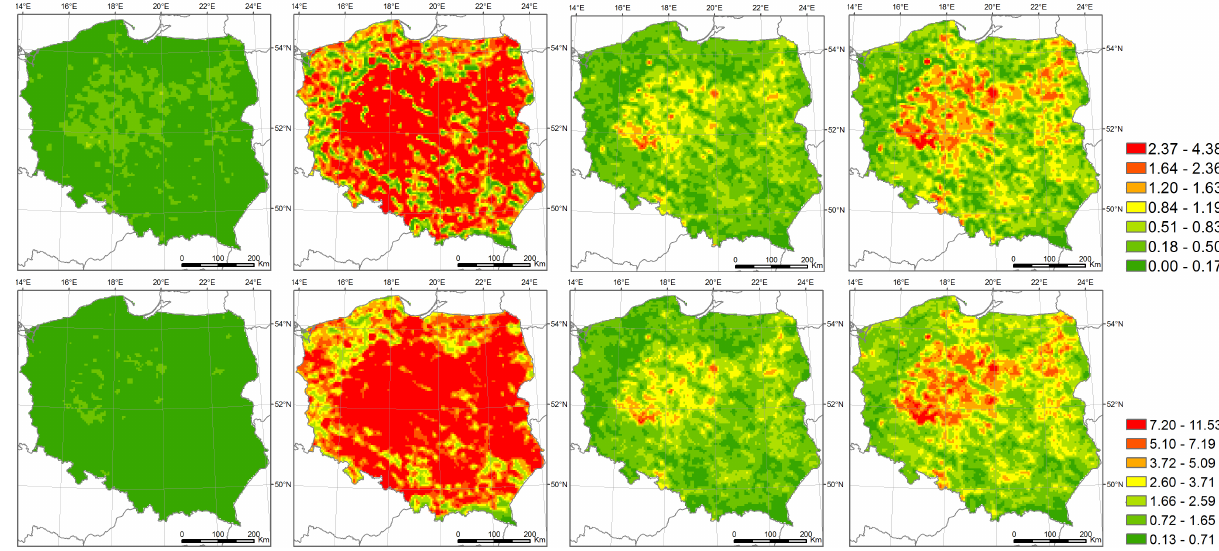
Figure 4. Top: spatial distribution of NH 3 emissions over Poland for February, April, June and September 2010 [kgha − 1 month − 1 ]. Bottom: monthly mean ammonia concentrations calculated with the FRAME model (POLREGUL) for February, April, June and September 2010 [µgm − 3 ].